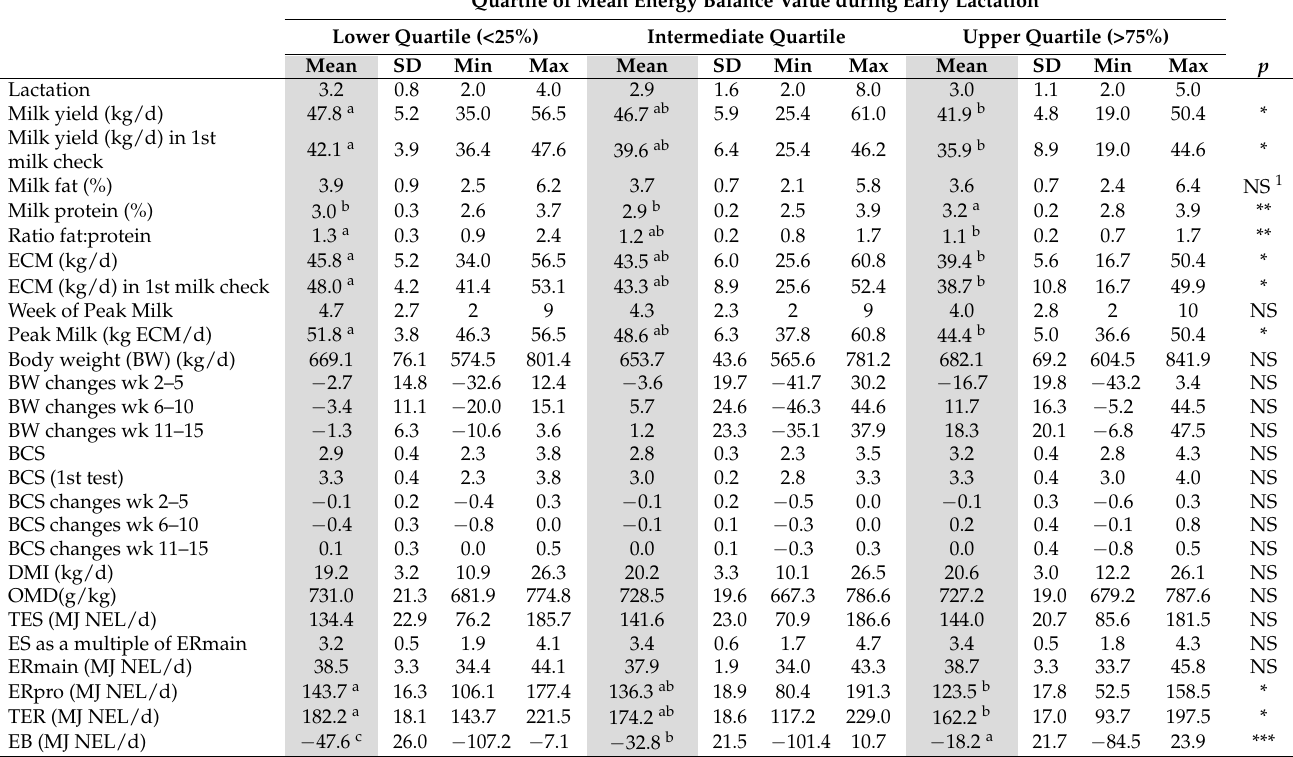
Table 3. Mean, SD, min, and max values of early lactating dairy cows grouped in quartiles according to mean energy balance observed between weeks 2 and 15 of lactation.